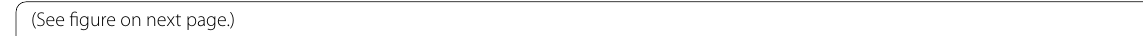
figure on next Fig. 10 Periprostatic leiomyoma a Axial and ( b ) Coronal T2W images demonstrate a right periprostatic mass (white arrow) which indents the right apex from below displacing it superiorly and to the left with mild distortion of the prostatic urethra. Relative to muscle, it is slightly T2 hyperintense with some intrinsic high T2 signal foci. c Axial T1W image shows the lesion is isointense to prostate and in ( d ) the lesion shows mild heterogeneous contrast enhancement. On DWI/ ADC, e , f respectively, the lesion showed some diffusion